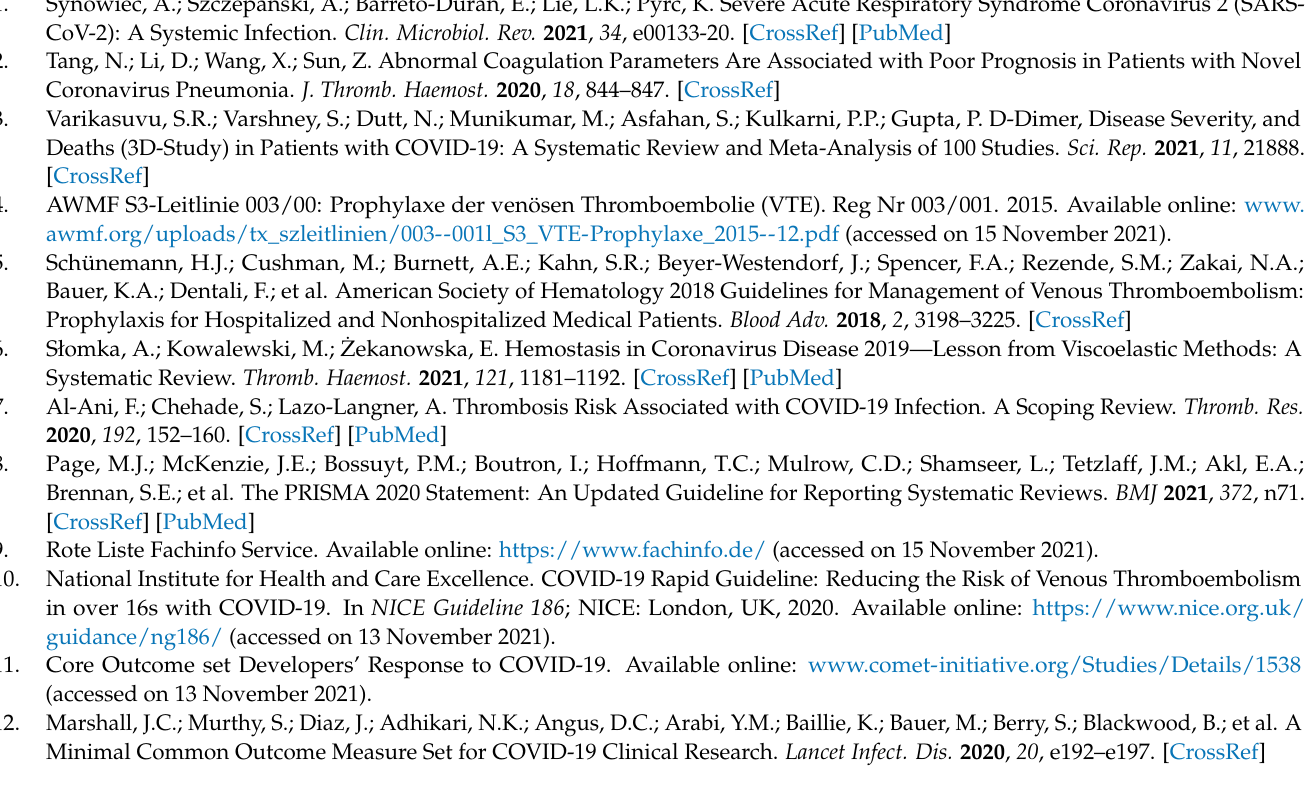
Table S2: Meta-analyses for therapeutic-dose anticoagulation according to pre-specified subgroups (moderately and severely diseased population) including certainty of evidence; Table S3: PRISMA 2020 checklist; Figure S1: Forest plots of intermediate-dose anticoagulation vs. standard dose thromboprophylaxis; Figure S2: Forest plots according to pre-specified subgroups (moderate and severe population) of therapeutic-dose anticoagulation vs. standard dose thromboprophylaxis; Search